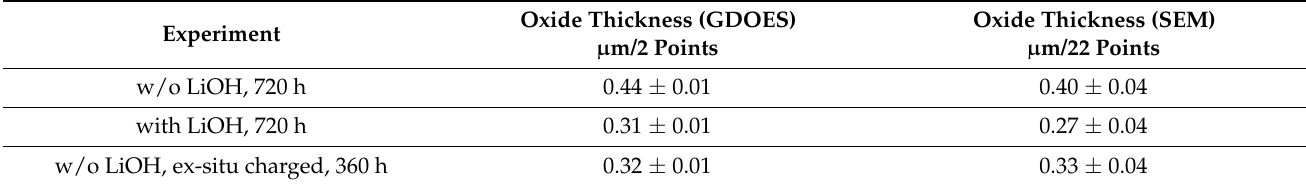
Table 2. Comparison of estimates of oxide thickness obtained by GDOES and SEM.